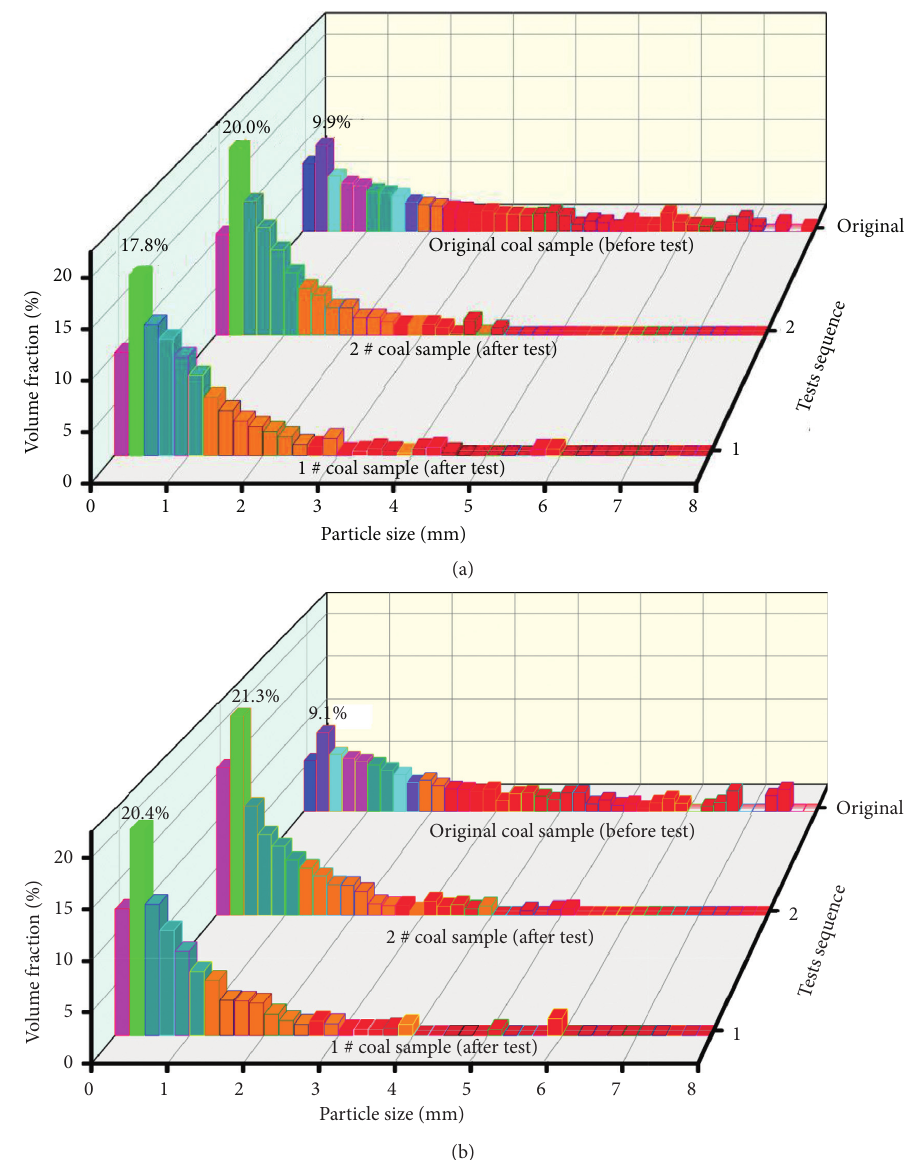
Figure 8: The histogram of particle size distribution before and after the tests. The volume fraction represents Feret’s minimum diameter volume distribution. (a) 1 # and 2 # coal sample. (b) 3 # and 4 # coal